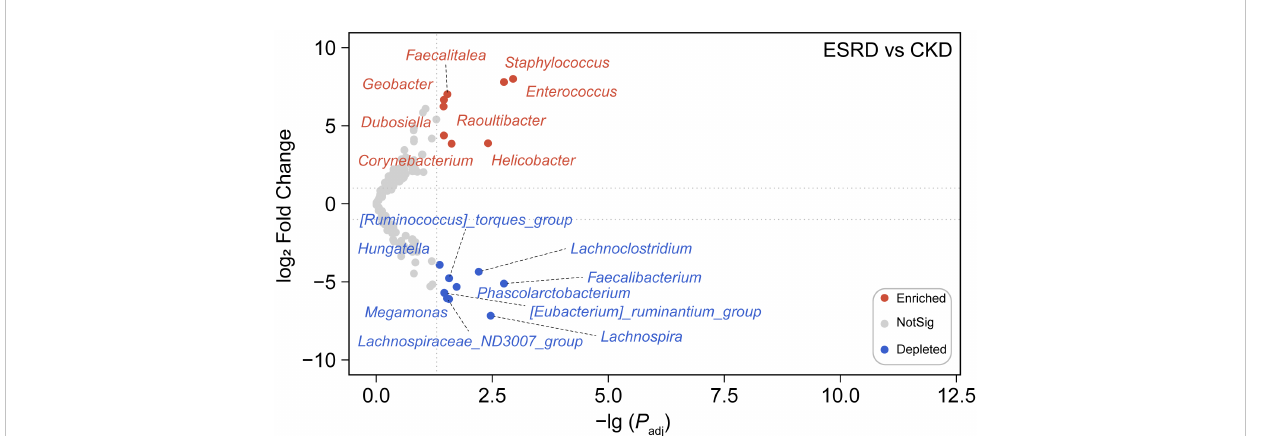
FIGURE 3 Differential abundance analysis at the genus level. The volcano revealed a marked difference in the abundance of certain genera between the ESRD group and the CKD group. The nodes in the plot were color-coded to re fl ect the type of change observed, blue dots indicate depleted genera, red dots indicate enriched genera, and gray dots indicate no signi fi cant difference between groups.